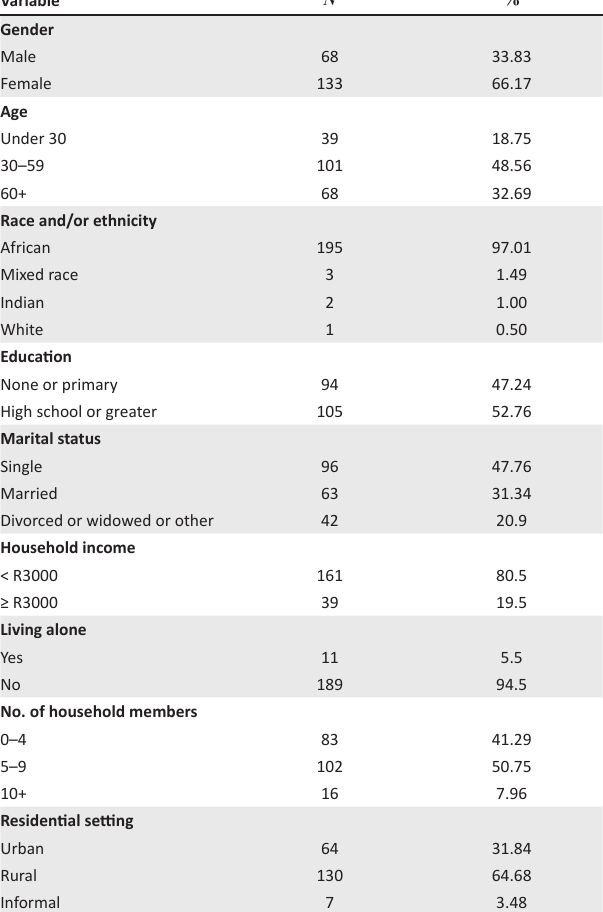
TABLE 1: Socio-demographic profiles.